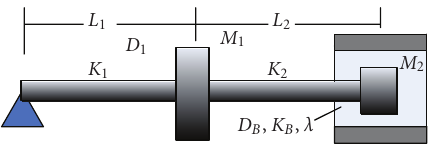
Figure 1: Two mass flexible rotor model.